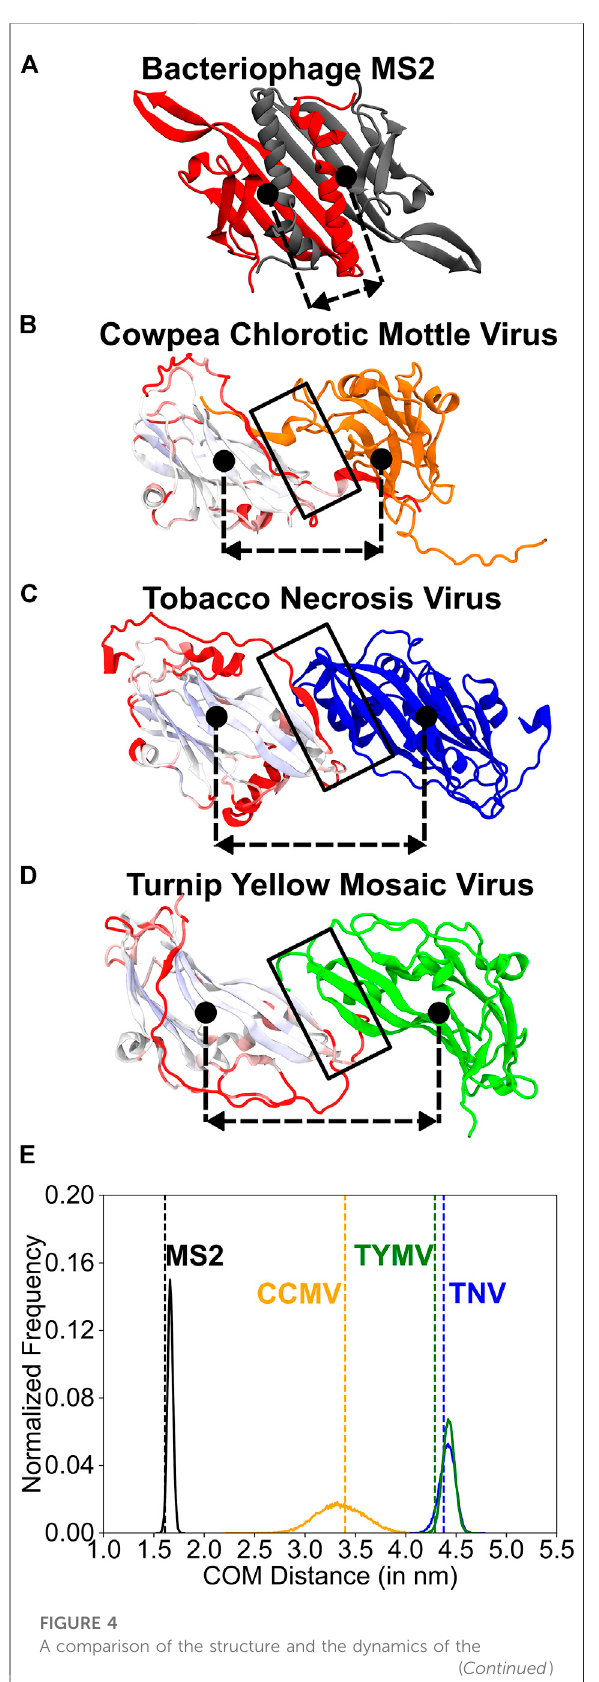
(dimerizationinterface).Thedimerizationinterfacesaremarkedby a black rectangle. The approximate position of the center of mass of each protein chain is indicated using a fi lled black circle. The dashed-double sided arrow indicates the distance between these centers of mass (COM distance). The COM distance distributionisplottedin (E) . (A) MS2(monomersingreyandred) (B) CCMV (graded and orange), (C) TNV (graded and blue) and (D) TYMV(gradedandgreen).Themonomersontheleftin (B – D) were structurallyalignedusingtheSTAMPalgorithm(RussellandBarton, 1992) within the Multiseq extension (Roberts et al., 2006) of the VMDpackage(Humphreyetal.,1996)andareshowninthealigned position. They are colored from blue through white to red based on how good the alignment is with blue indicating a good alignment and red indicating no alignment. The core β -sheet jelly- rollfold(palebluetowhite)alignswellacrossthethreeviruses.The change in orientation in the right monomer (orange, blue and green)isduetothedistinctdimerinterfacesinthethreeviruses. (E) Histograms of the COM distance calculated from equal time coarse-grained simulations of the dimers. The vertical dashed line (colored like the histogram) shows the COM distance in the native folded structure. MS2-CP2: mean COM distance = 1.67 nm, standard deviation = 0.03 nm. TNV-CP2: mean = 4.42 nm, standard deviation = 0.08 nm. TYMV-CP2: mean = 4.43 nm,